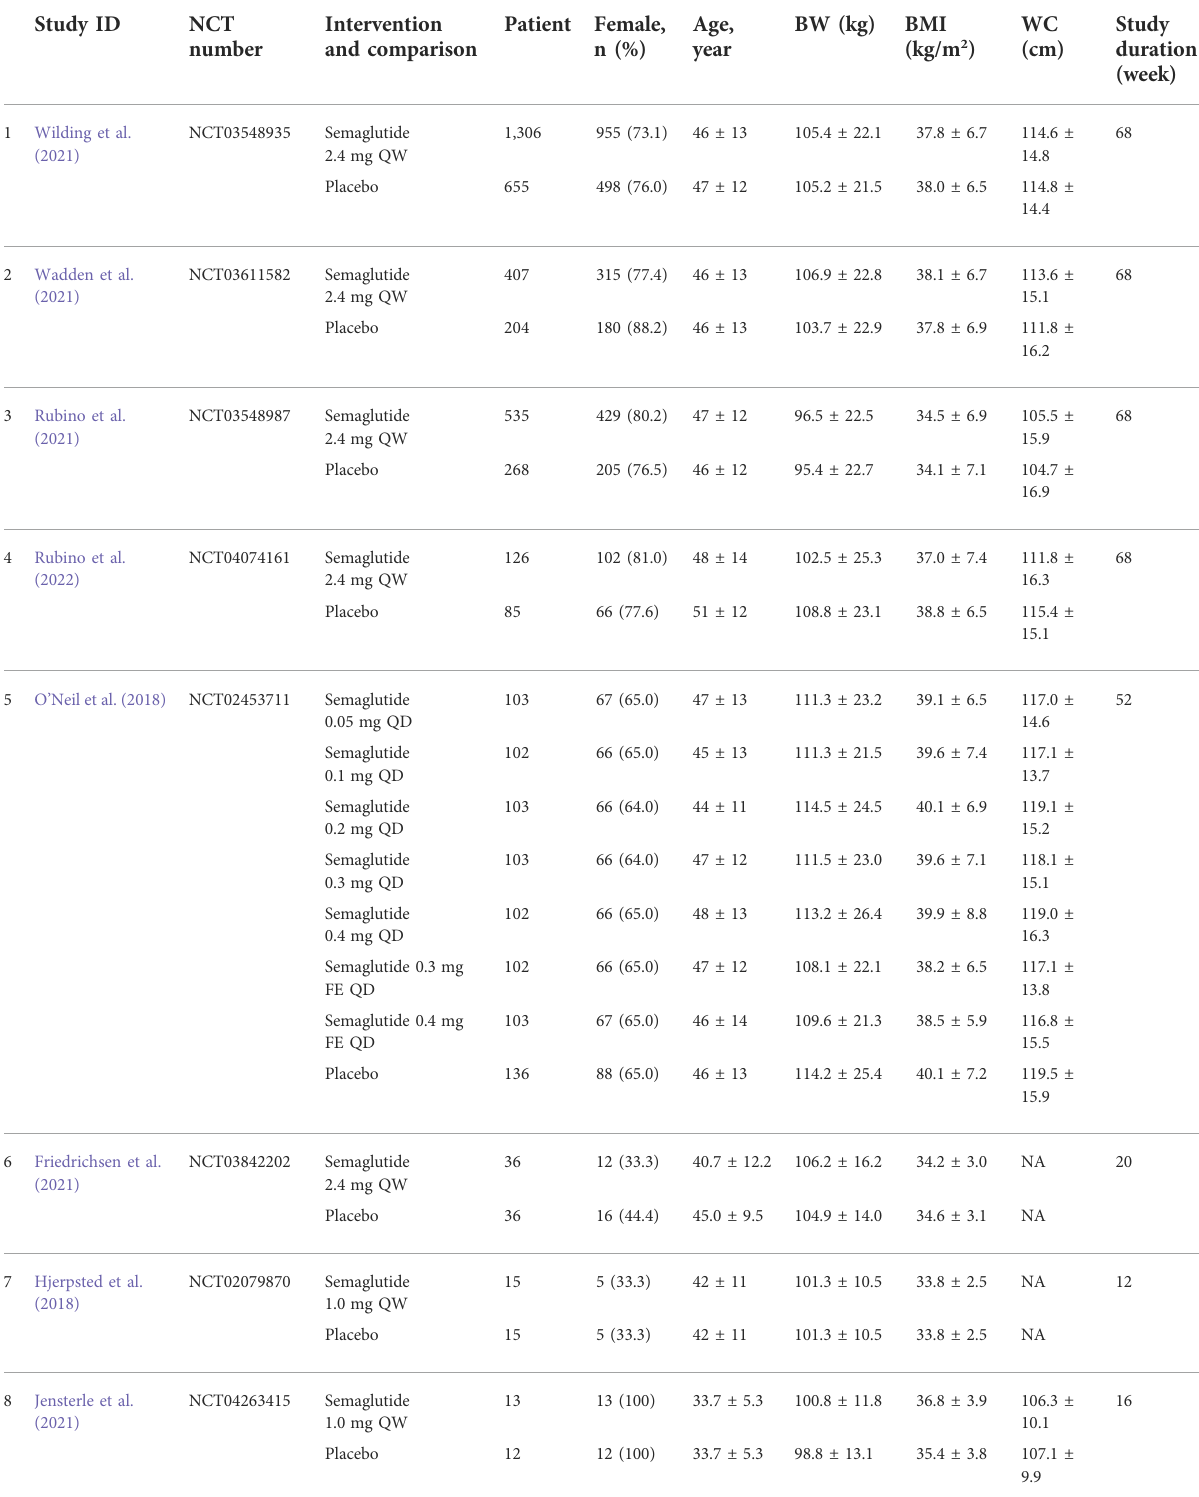
TABLE 1 Characteristics of included